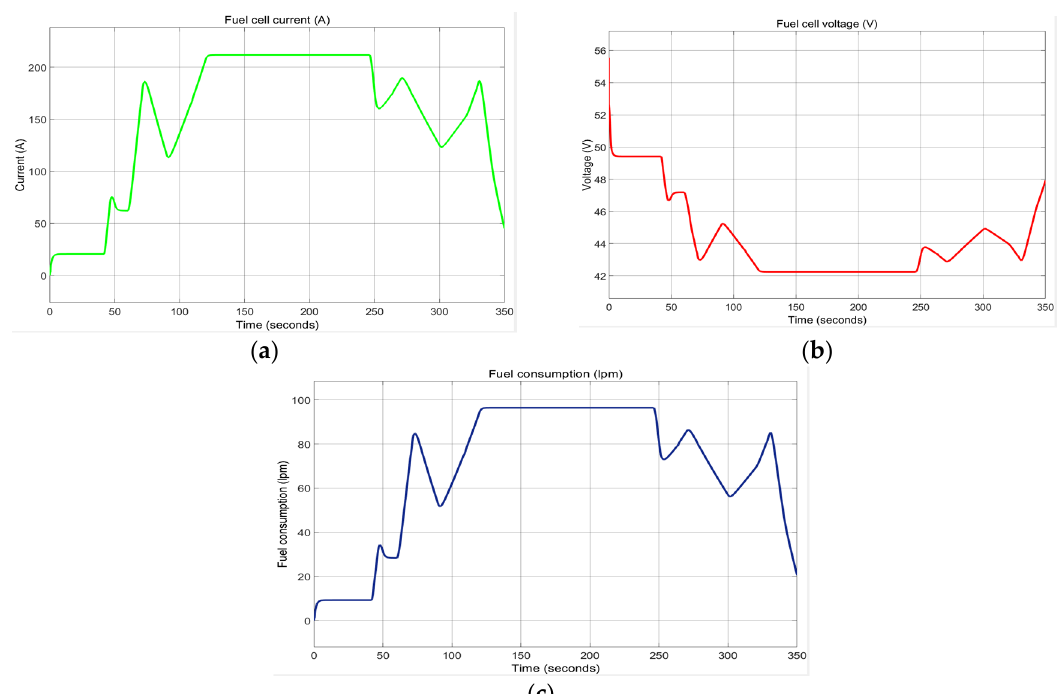
Figure A4. Fuel cell. ( a ) FC current; ( b ) FC voltage; ( c ) FC consumption.